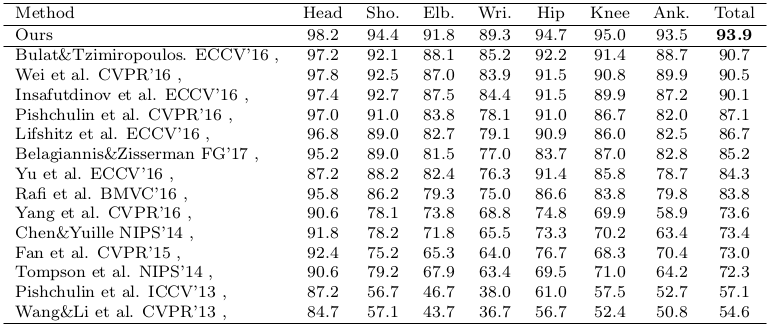
Table from the paper: Knowledge-Guided Deep Fractal Neural Networks for Human Pose Estimation
Table text:
Method
Head
Sho.
Elb.
Wri.
Hip
Knee
Ank.
Total
Ours
98.2
94.4
91.8
89.3
94.7
95.0
93.5
93.9
Bulat&Tzimiropoulos. ECCV’16 ,
97.2
92.1
88.1
85.2
92.2
91.4
88.7
90.7
Wei et al. CVPR’16 ,
97.8
92.5
87.0
83.9
91.5
90.8
89.9
90.5
Insafutdinov et al. ECCV’16 ,
97.4
92.7
87.5
84.4
91.5
89.9
87.2
90.1
Pishchulin et al. CVPR’16 ,
97.0
91.0
83.8
78.1
91.0
86.7
82.0
87.1
Lifshitz et al. ECCV’16 ,
96.8
89.0
82.7
79.1
90.9
86.0
82.5
86.7
Belagiannis&Zisserman FG’17 ,
95.2
89.0
81.5
77.0
83.7
87.0
82.8
85.2
Yu et al. ECCV’16 ,
87.2
88.2
82.4
76.3
91.4
85.8
78.7
84.3
Raﬁ et al. BMVC’16 ,
95.8
86.2
79.3
75.0
86.6
83.8
79.8
83.8
Yang et al. CVPR’16 ,
90.6
78.1
73.8
68.8
74.8
69.9
58.9
73.6
Chen&Yuille NIPS’14 ,
91.8
78.2
71.8
65.5
73.3
70.2
63.4
73.4
Fan et al. CVPR’15 ,
92.4
75.2
65.3
64.0
76.7
68.3
70.4
73.0
Tompson et al. NIPS’14 ,
90.6
79.2
67.9
63.4
69.5
71.0
64.2
72.3
Pishchulin et al. ICCV’13 ,
87.2
56.7
46.7
38.0
61.0
57.5
52.7
57.1
Wang&Li et al. CVPR’13 ,
84.7
57.1
43.7
36.7
56.7
52.4
50.8
54.6